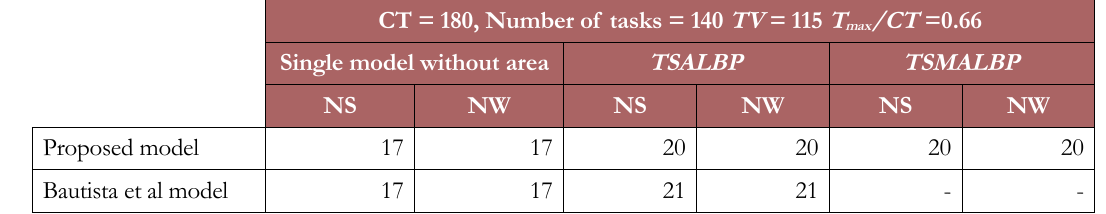
Table 6. The results of real-life problem of Nissan plant in Spain